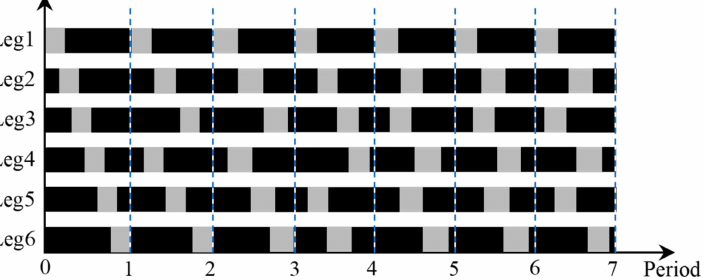
Figure 10. Visualization of legs’ phase for the RL-based gaits. Black rectangles indicate support phases, gray rectangles indicate swing phases and block lengths indicate duration. The hexapod robot walked with a wave-like gait in the first cycle, a quadruped-like gait in the second to fourth cycles, and finally walked in a tripod-like gait. Within each gait cycle, RL-based gait had a different duty cycle and phase